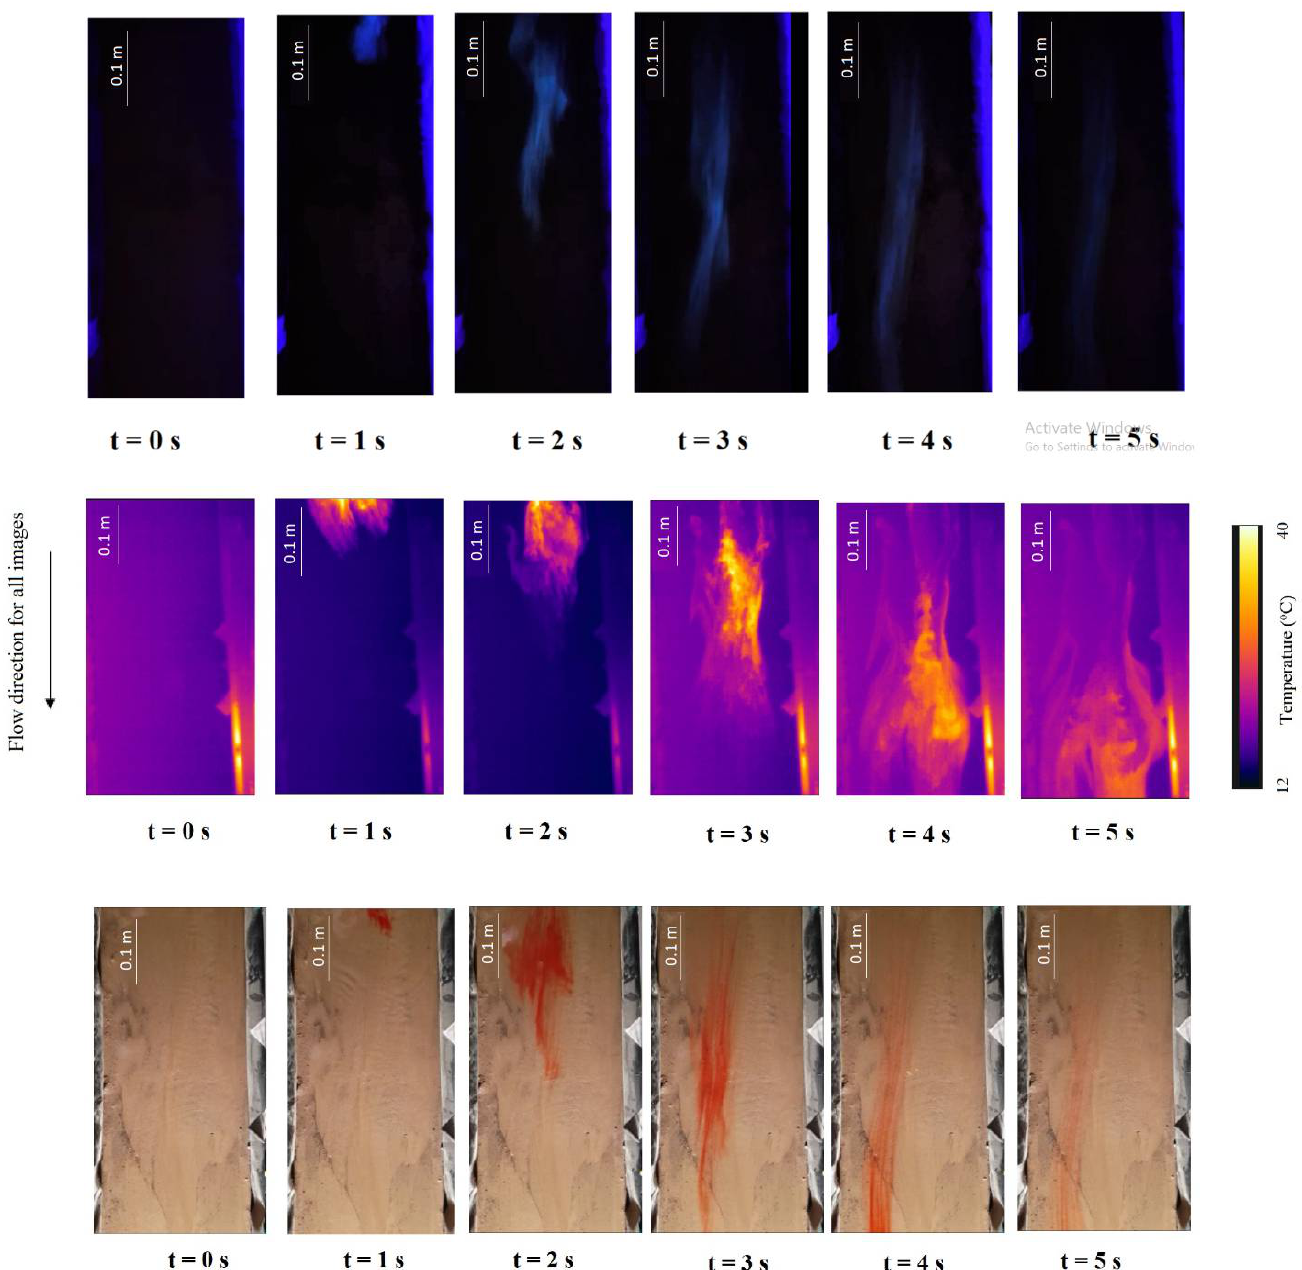
Figure 5. Chronological sequence of snapshots for overland flow tests, with a time lapse of 1 s, for: quinine tracer ( top ), thermal tracer ( middle ), and dye tracer ( bottom ) measurements. Snapshots of the scanned surface area are from the flat plane surface (see Figure 2). The blue intermittent marks ( top ) on the sides of the scanning area are reflections captured by the camera, and should be disregarded.